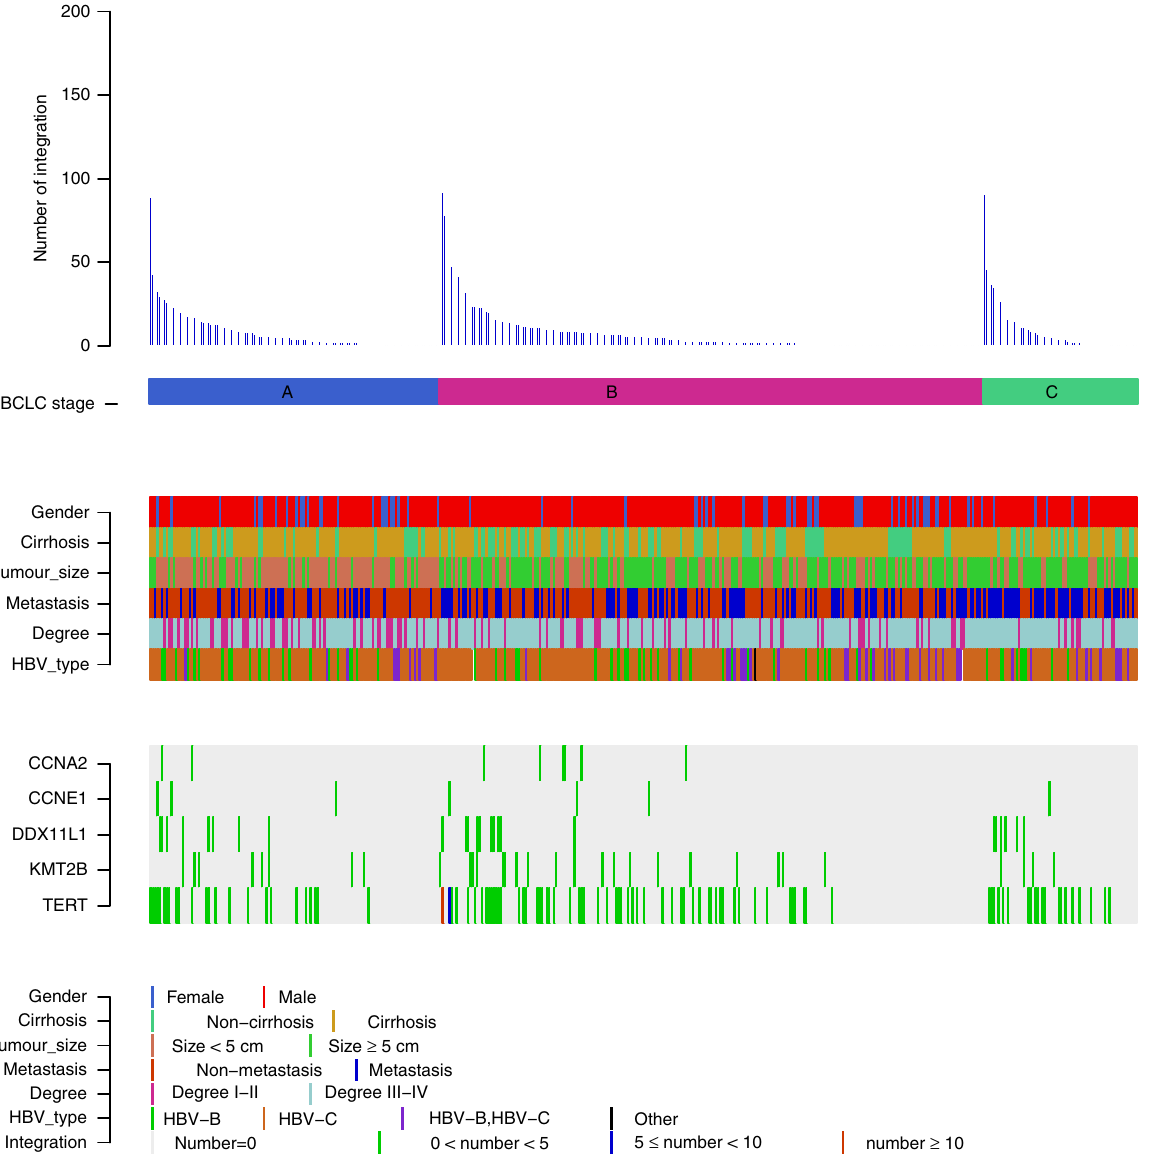
Figure 5 | Clinical annotation of HBV integration sites in 426 HCC samples. All panels are aligned with vertical tracks representing 426 individuals. The data are sorted by BCLC stage, gender, cirrhosis, tumour size, metastasis, Edmonson-Steiner classification and HBV type. The bottom heat map shows the distribution of HBV integrations into the five recurrent HBV targeted genes in HCC